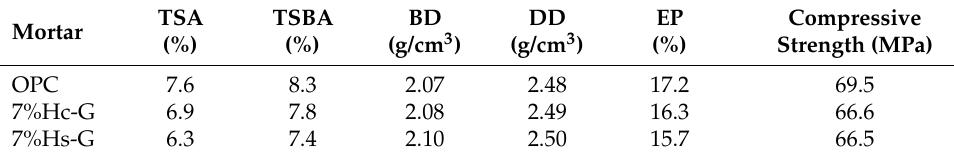
Table 3. Physical and mechanical parameters of the mortars under